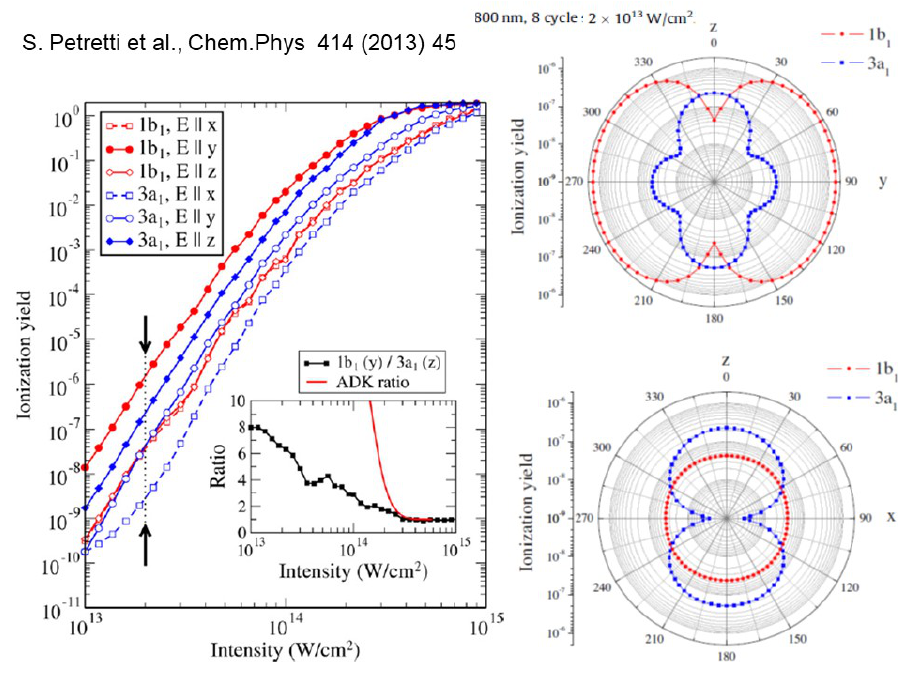
Figure 8. Strong field ionization yield in water (from [56] with permission).